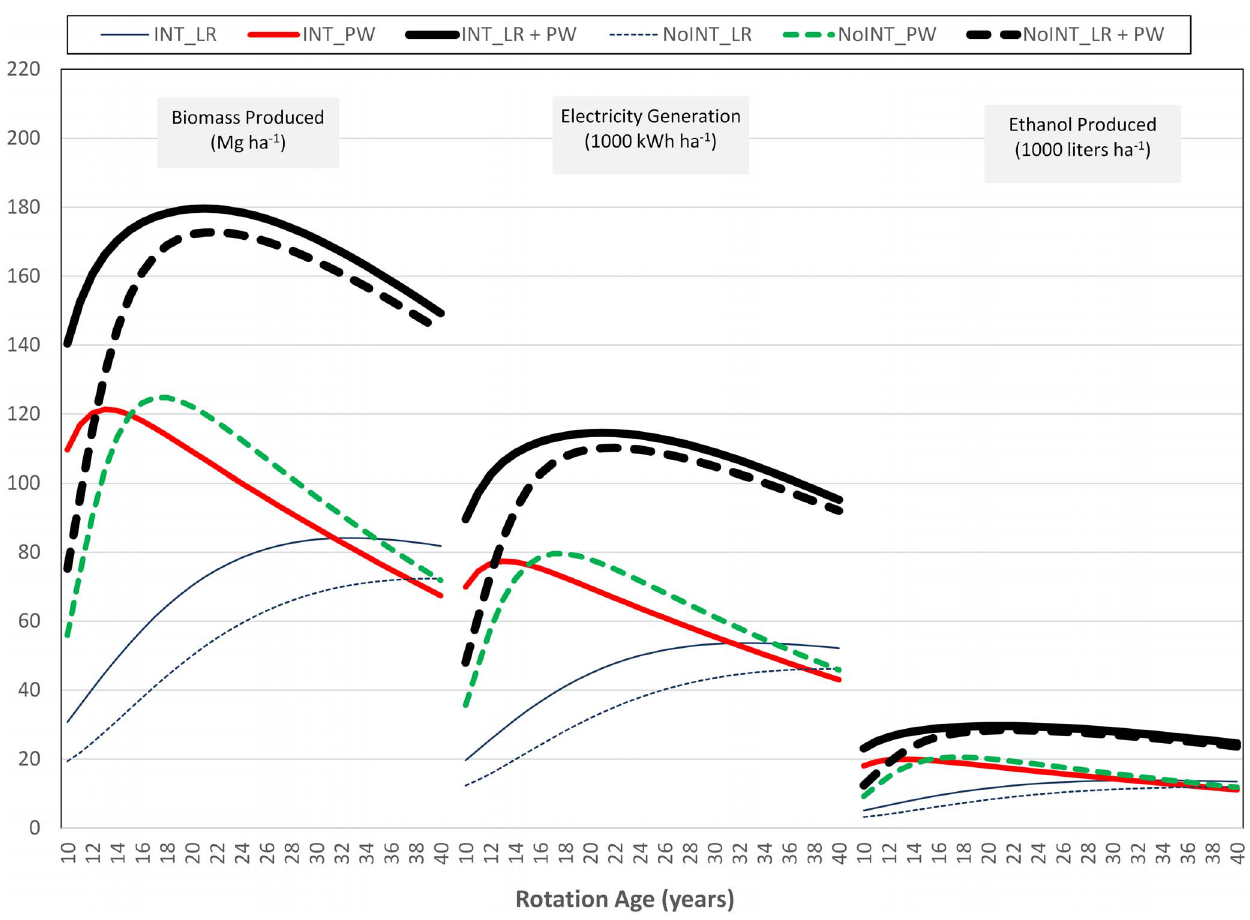
Figure 3. Availability of feedstocks, electricity generated, and ethanol produced. LR: logging residues; PW: pulpwood; INT: intensive forest management; NoINT: non-intensive forest management.